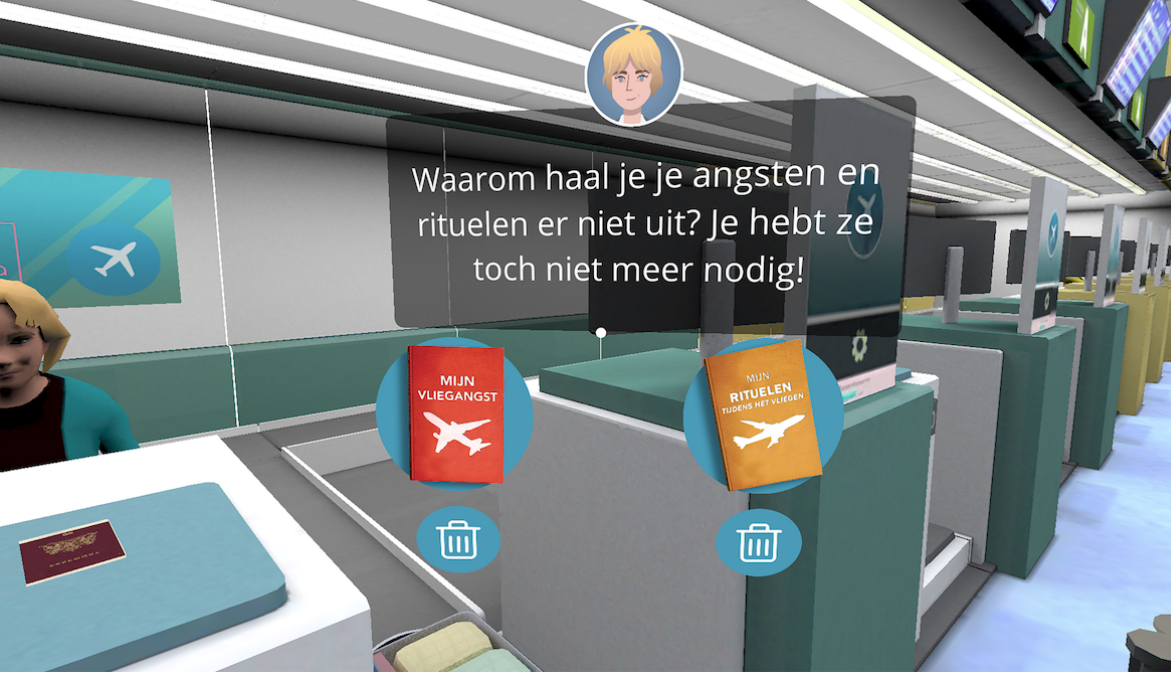
Figure 5. Virtual Reality Level 4: Taking